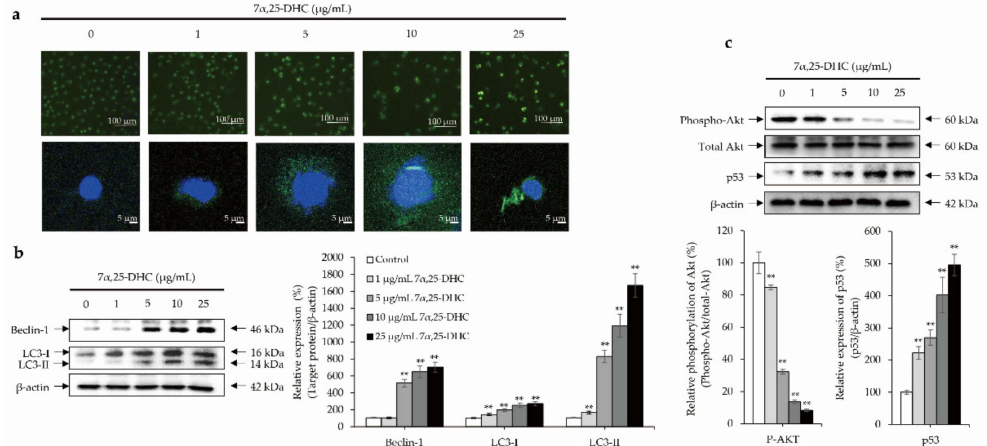
Figure 7. 7 α ,25-DHC induced autophagy through Akt/p53 crosstalk in L929 cells. L929 cells were incubated with 1, 5, 10, or 25 µ g/mL 7 α ,25-DHC for 48 h. Thereafter, autophagy staining was performed by an autophagy detection kit. Images were taken by a laser confocal scanning microscope. In addition, Total proteins were extracted using cell lysis buffer and then quantified by BCA assay kit. Sequentially, equal concentration of protein samples was loaded onto SDS-PAGE gels to perform Western blotting using beclin-1 and LC3 antibodies. Immunoreactive bands were exposed by ECL solution and acquired under microChemi 4.2. Results were presented as the relative ratio of target protein/ β -actin, ** p < 0.01. β -actin was used as an internal control. ( a ) Autophagy-positive cell numbers were increased by 7 α ,25-DHC in L929 cells. Autophagic vacuoles and nucleus of cells